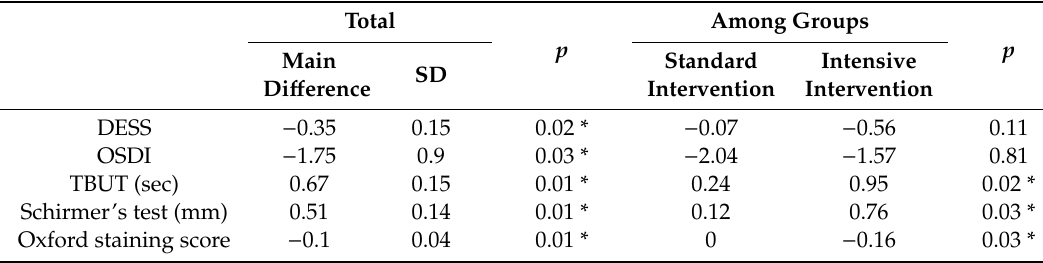
Table 4. Clinical parameters